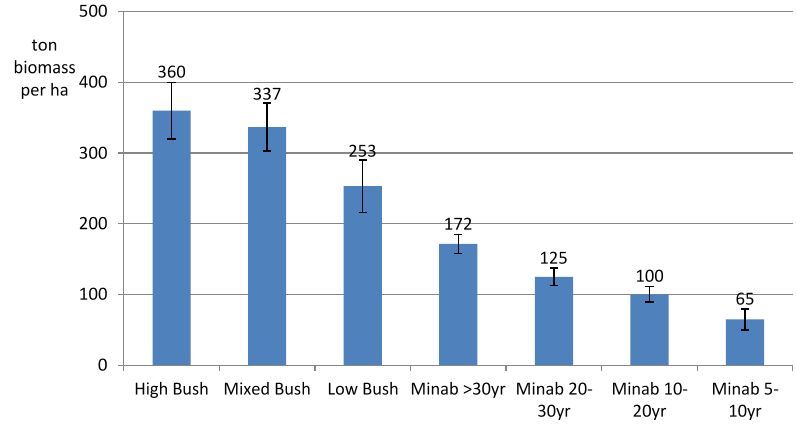
Figure 6. Aboveground biomass per hectare in different forest types in the North